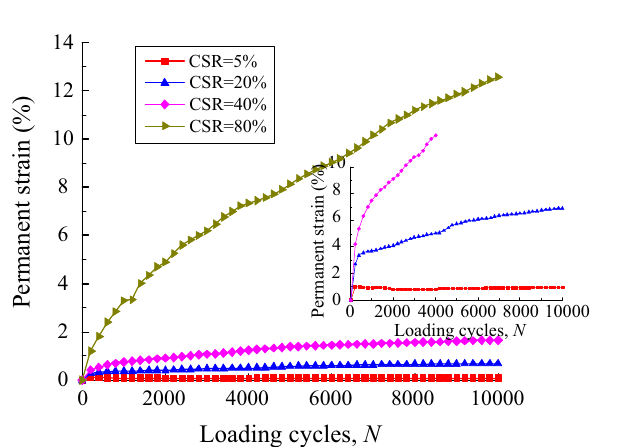
Figure 13. DEM-calculated permanent strain plotted against loading cycles for UGM samples at different